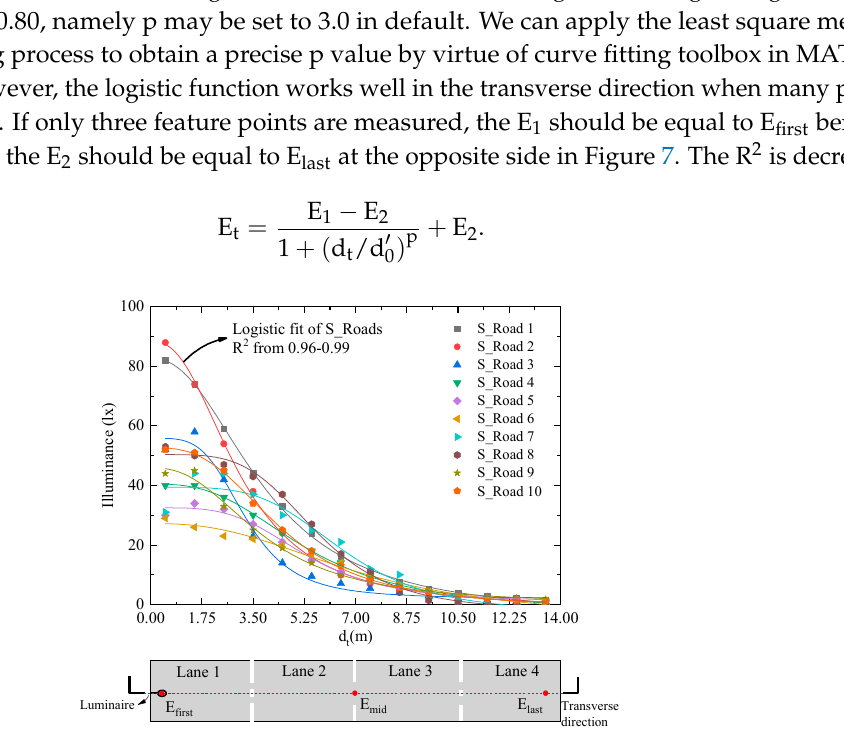
Figure 7. Illuminance distributions in the transverse direction (red-dashed line) start from the illuminance beneath the luminaire. The S_Roads represent the 10 simulated road lightings.